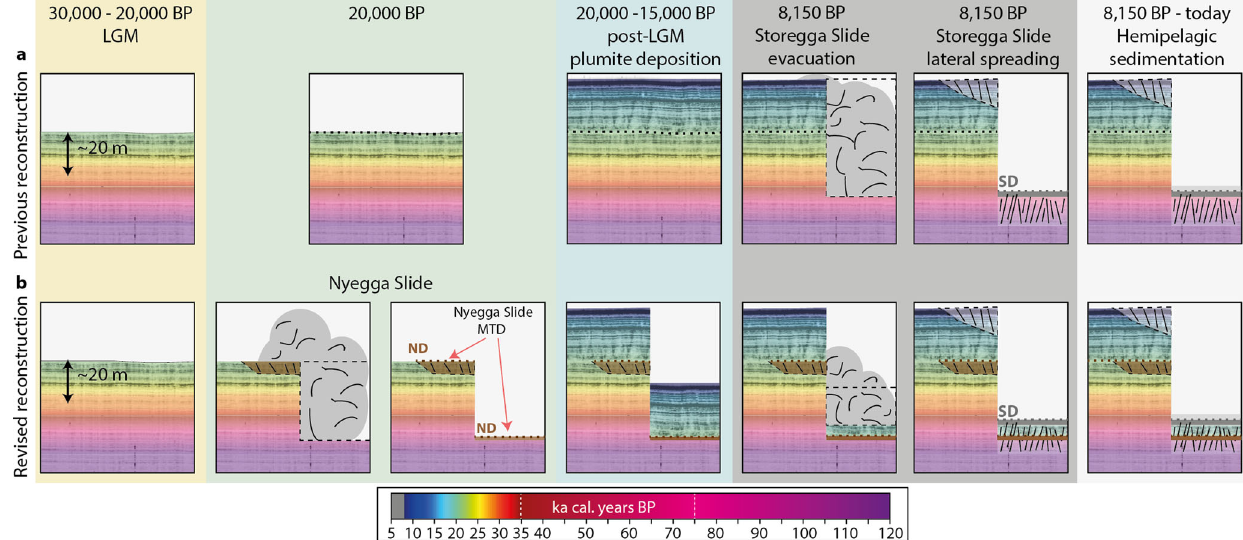
Fig. 6 Comparison between the previous and revised reconstruction of slope failure. a The “ previous reconstruction ” assumes that the NE slide scar evacuation occurred solely during the 8,150 BP Storegga Slide event and removed all sediments younger than 30,000 years. b The revised reconstruction (this study) shows that most of the slide scar evacuation occurred during the ~20,000 BP Nyegga Slide event and that the Storegga Slide only removed parts of the post-LGM sediment cover. Colour shading-age relationship is the same as de fi ned in Fig. 2a and is shown again here